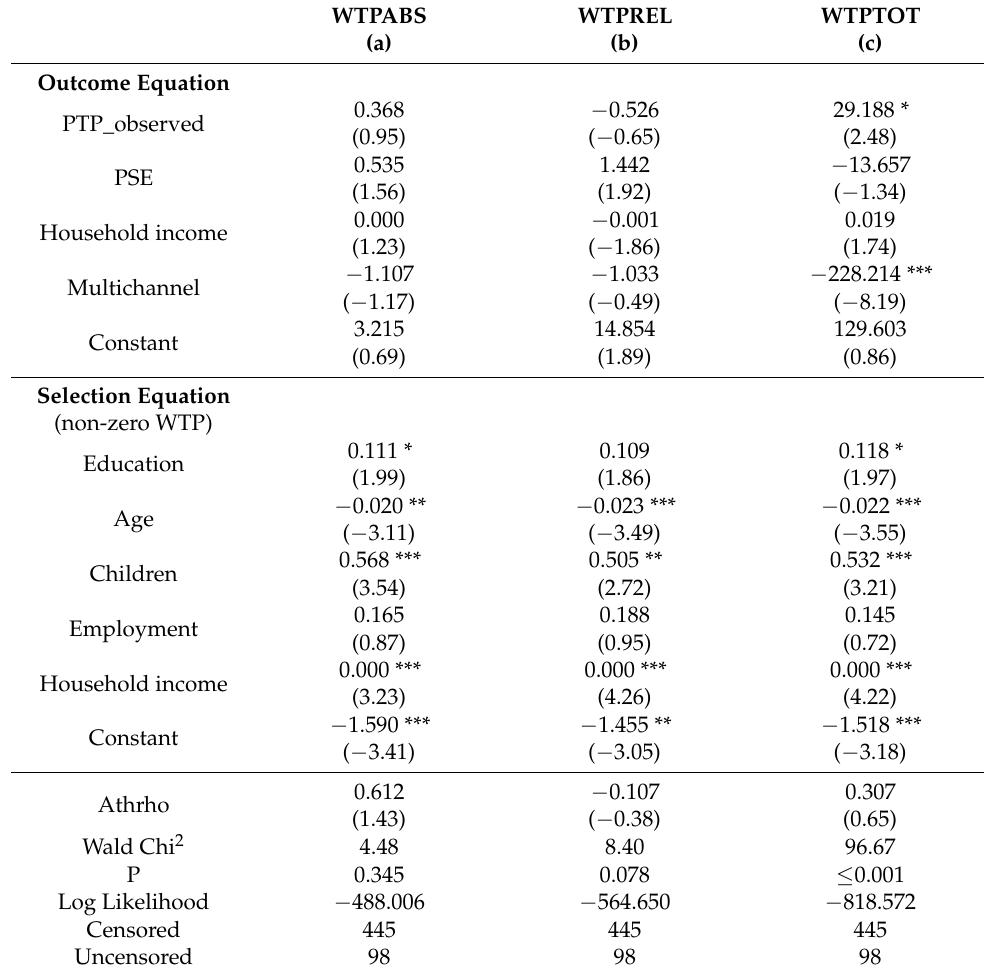
Table 7. Heckman results for the